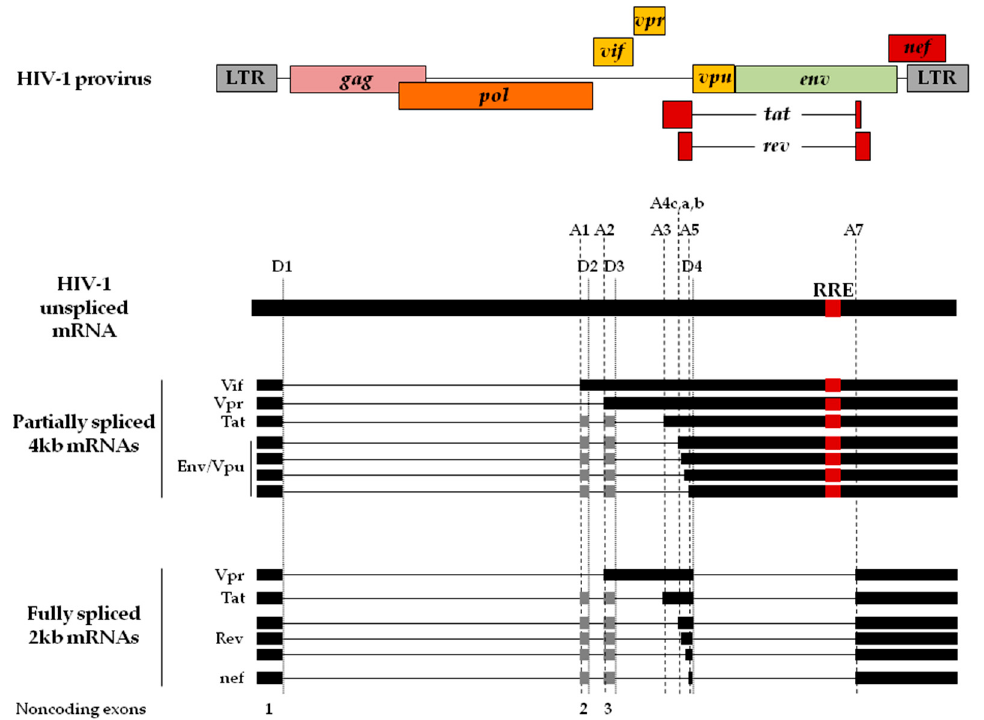
Figure 2. Schematic representation of the HIV-1 genome. The different colored boxes indicate the HIV-1 ORFs located between the two LTRs. Position of the conserved donor (D1 to D4) and acceptor (A1 to A7) sites are shown. The HIV-1 primary transcript serves as both mRNA that encodes for the Gag and Gag-Pol polyproteins and as genomic RNA. The red RRE box corresponds to the binding site of Rev, which is required for the nuclear export of partially spliced and unspliced RNA transcripts. The exons of the partially and fully spliced mRNAs are shown in black boxes. The first exon is a noncoding exon (exon 1) present in all HIV-1 transcripts. Either both or one of the small noncoding exons 2 and 3 (grey boxes) are included in a fraction of the corresponding mRNA species leading to the diversity of the HIV-1 mRNAs.